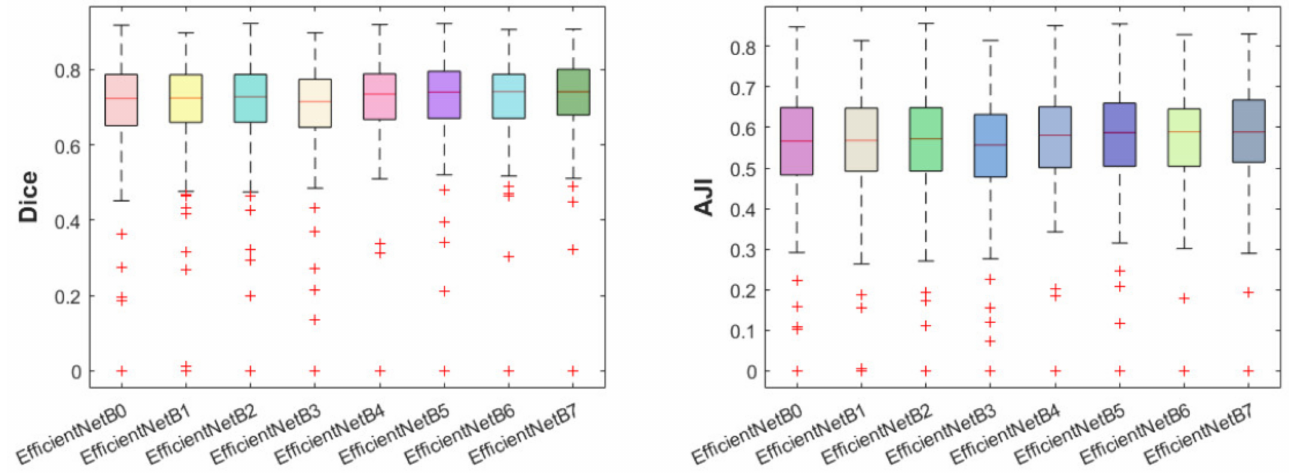
Figure A2. The box plots of Dice and AJI scores for all the test data sets. Different boxes with colours represent the different versions of the EfficientNet backbone. The median value of every box is the red line inside the box; the outliers are labelled as the red (+)